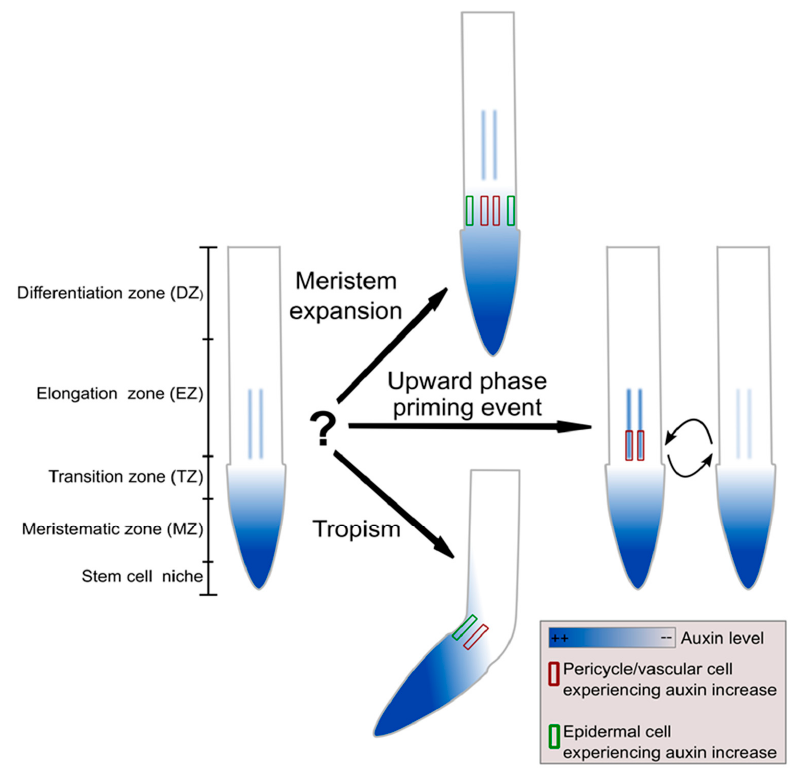
Figure 1. How can an individual plant cell deduce sufficient information from a locally perceived auxin increase? An increase in auxin experienced by an individual cell may reflect a long-term, tissue wide increase in auxin that will result in meristem expansion ( upper graph , perceived in both epidermal and vascular cells), alternatively it may represent the upward phase of the oscillatory lateral root priming process ( middle graph , predominantly perceived in vascular cells) and finally it may arise from tropism ( lower graph , perceived in epidermal and possibly vascular cells). Thus, for an individual epidermal or vascular cell, a perceived auxin increase may arise from at least two of these three different situations, for which a different response is